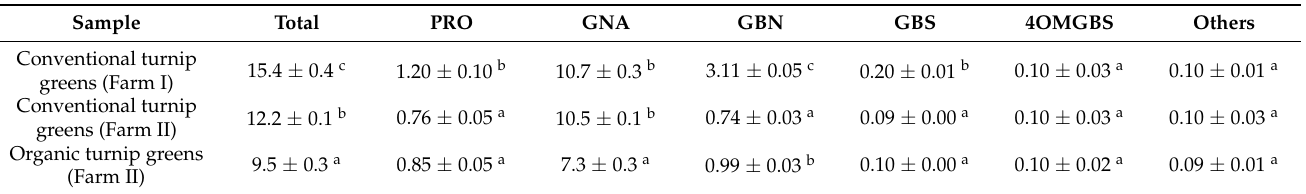
Table 8. Bioaccessible content ( µ mol/g dry weight) of total and individual glucosinolates in turnip greens (mean ± standard deviation).